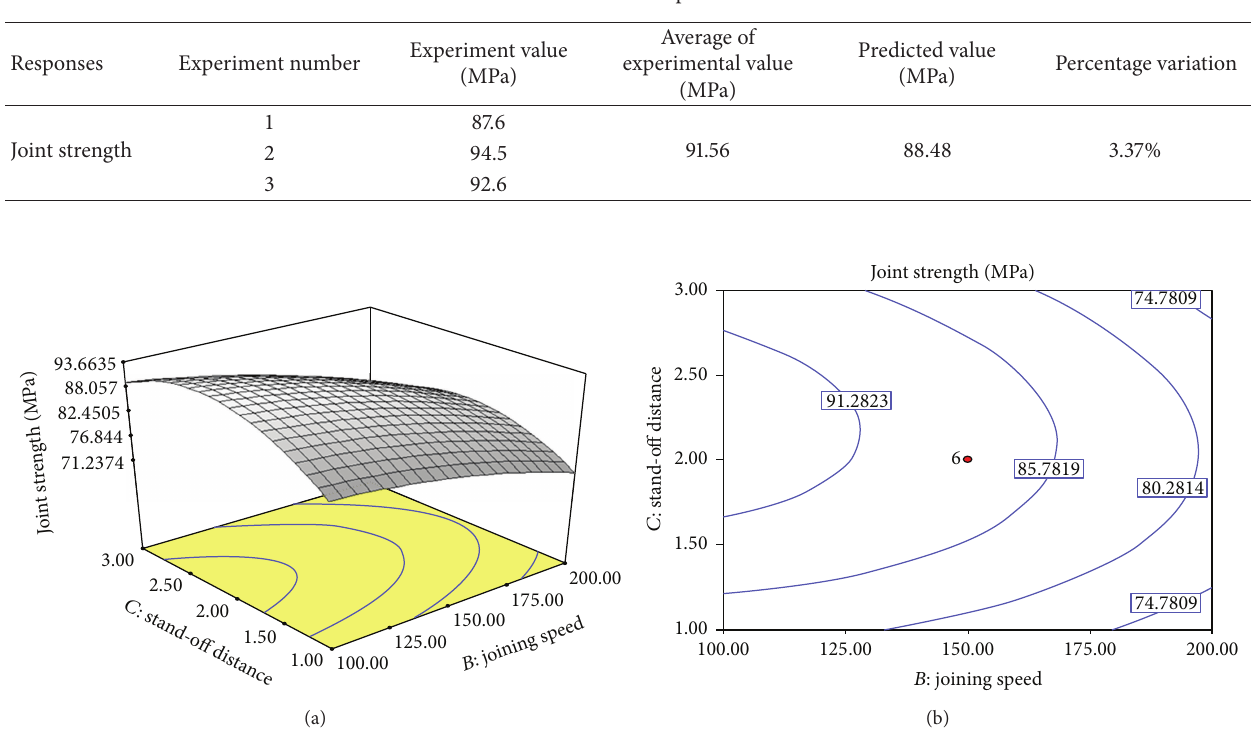
Figure 10: Interaction effect of joining speed and stand-off distance on the joint strength. (a) 3D interaction; (b) the contour